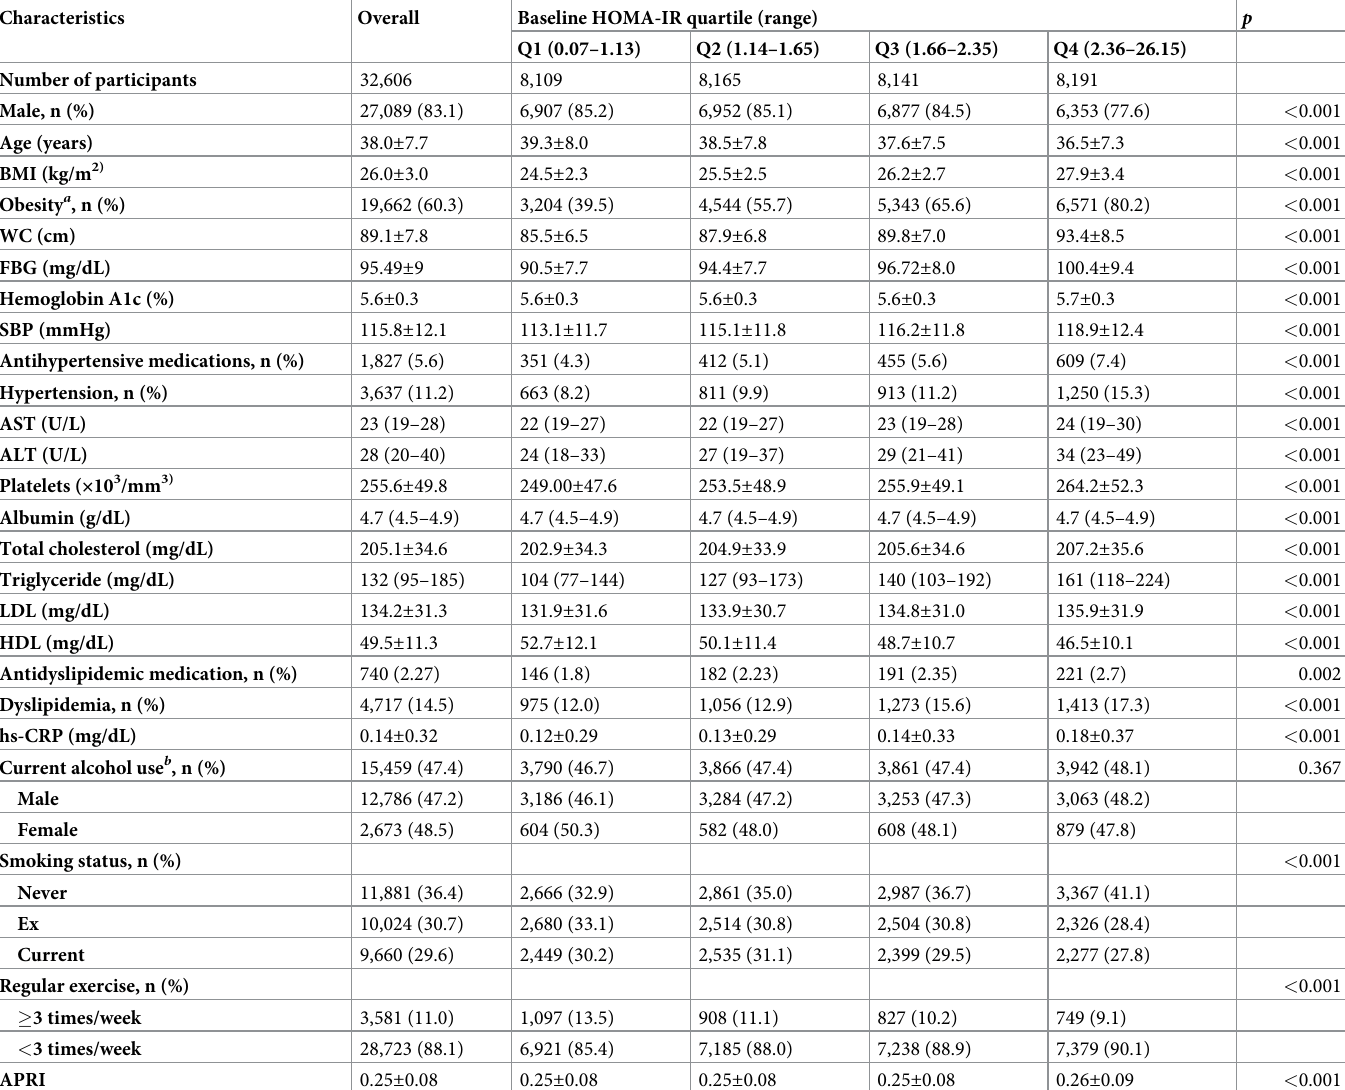
Table 1. Baseline characteristics of participants by HOMA-IR quartile at baseline.